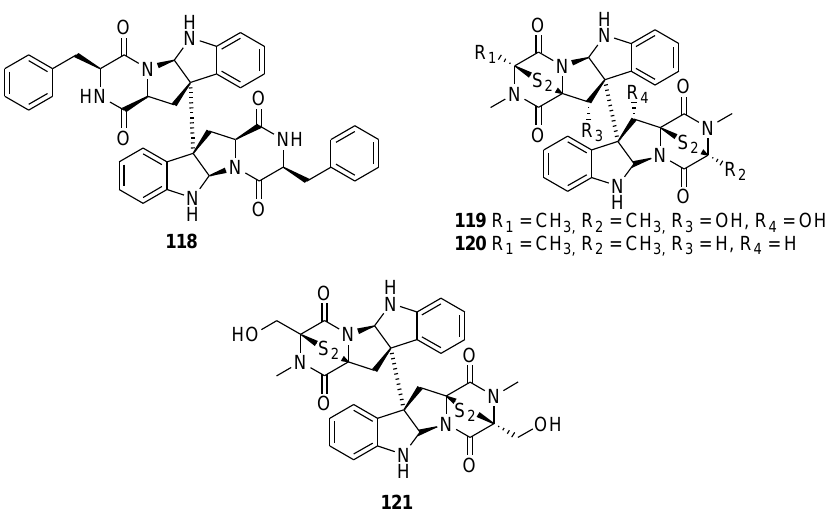
Figure 22. Representation of biologically active diketopiperazine dimers produced by marine mi- croorganisms.